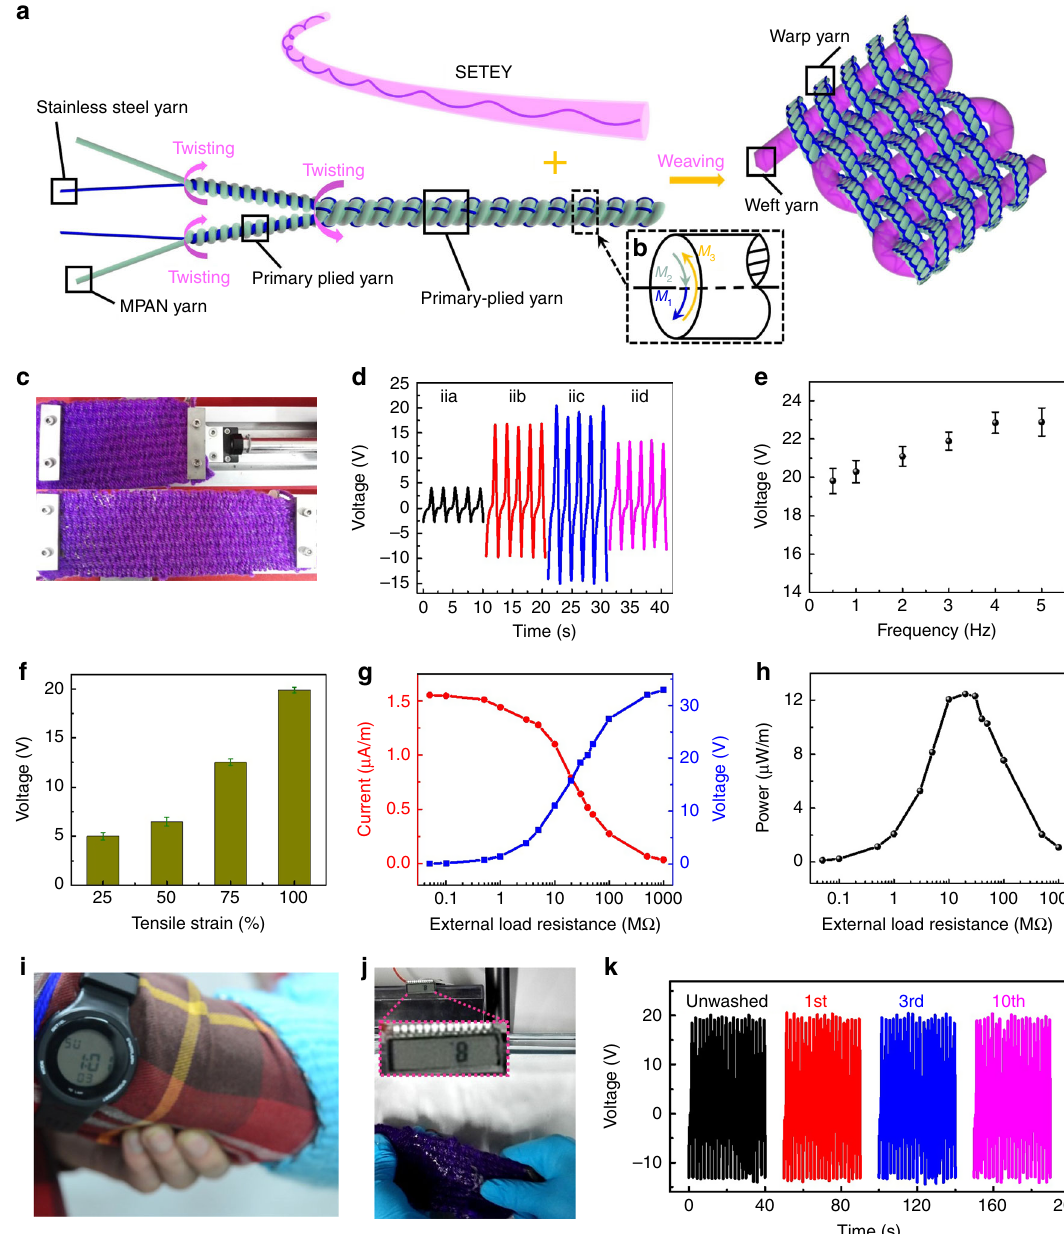
Fig. 4 Structure design and electrical output performance of the energy textiles. a Fabrication processes of the e-textile. b Resultant torsional moment diagram of the double-plied yarn. M 1 and M 2 are the torsional moments of the two primary plied yarn, respectively. M 3 is the torsional moment of the double-plied yarn. Their resultant torsional moment is 0, namely M 3 = M 1 + M 2 . c Photographs of the experiment setup with a stretch-retraction mode. d Electrical outputs of four distinct patterns measured under 100% tensile strain at a fi xed frequency of 0.5 Hz. e Output voltage of the warp-weft- connection single-electrode e-textile measured at different frequency (0.5 – 5 Hz) with a 100% tensile strain. The error bars correspond to standard deviation caused by the measurement noise. f Output performance of the warp-weft-connection single-electrode e-textile measured under different tensile strain (25, 50, 75 and 100%). The error bars correspond to standard deviation caused by the statistical uncertainty of measurement. g Output current/ voltage, and h power of the warp-weft-connection single-electrode e-textile measured at different external load resistances varied from 50 K Ω to 1 G Ω with a fi xed frequency of 0.5 Hz. i An image of a self-charging system that harvests biomechanical energy by the e-textile to power an electronic watch. j A snapshot of an e-textile working underwater. k The electrical output results of the e-textile after repeated